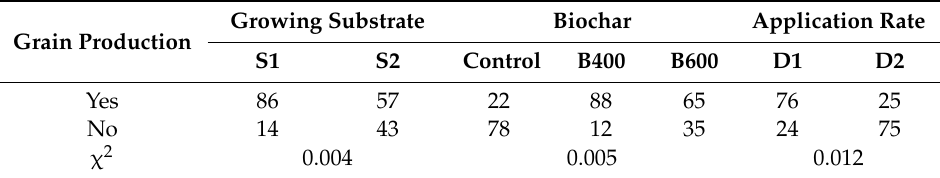
Table 6. Summarized contingency tables for sorghum plants grain production (% plants) under di ff erent treatments (growing substrate S1: sandy-loam; growing substrate S2: clay-loam; B400—Biochar 400 ◦